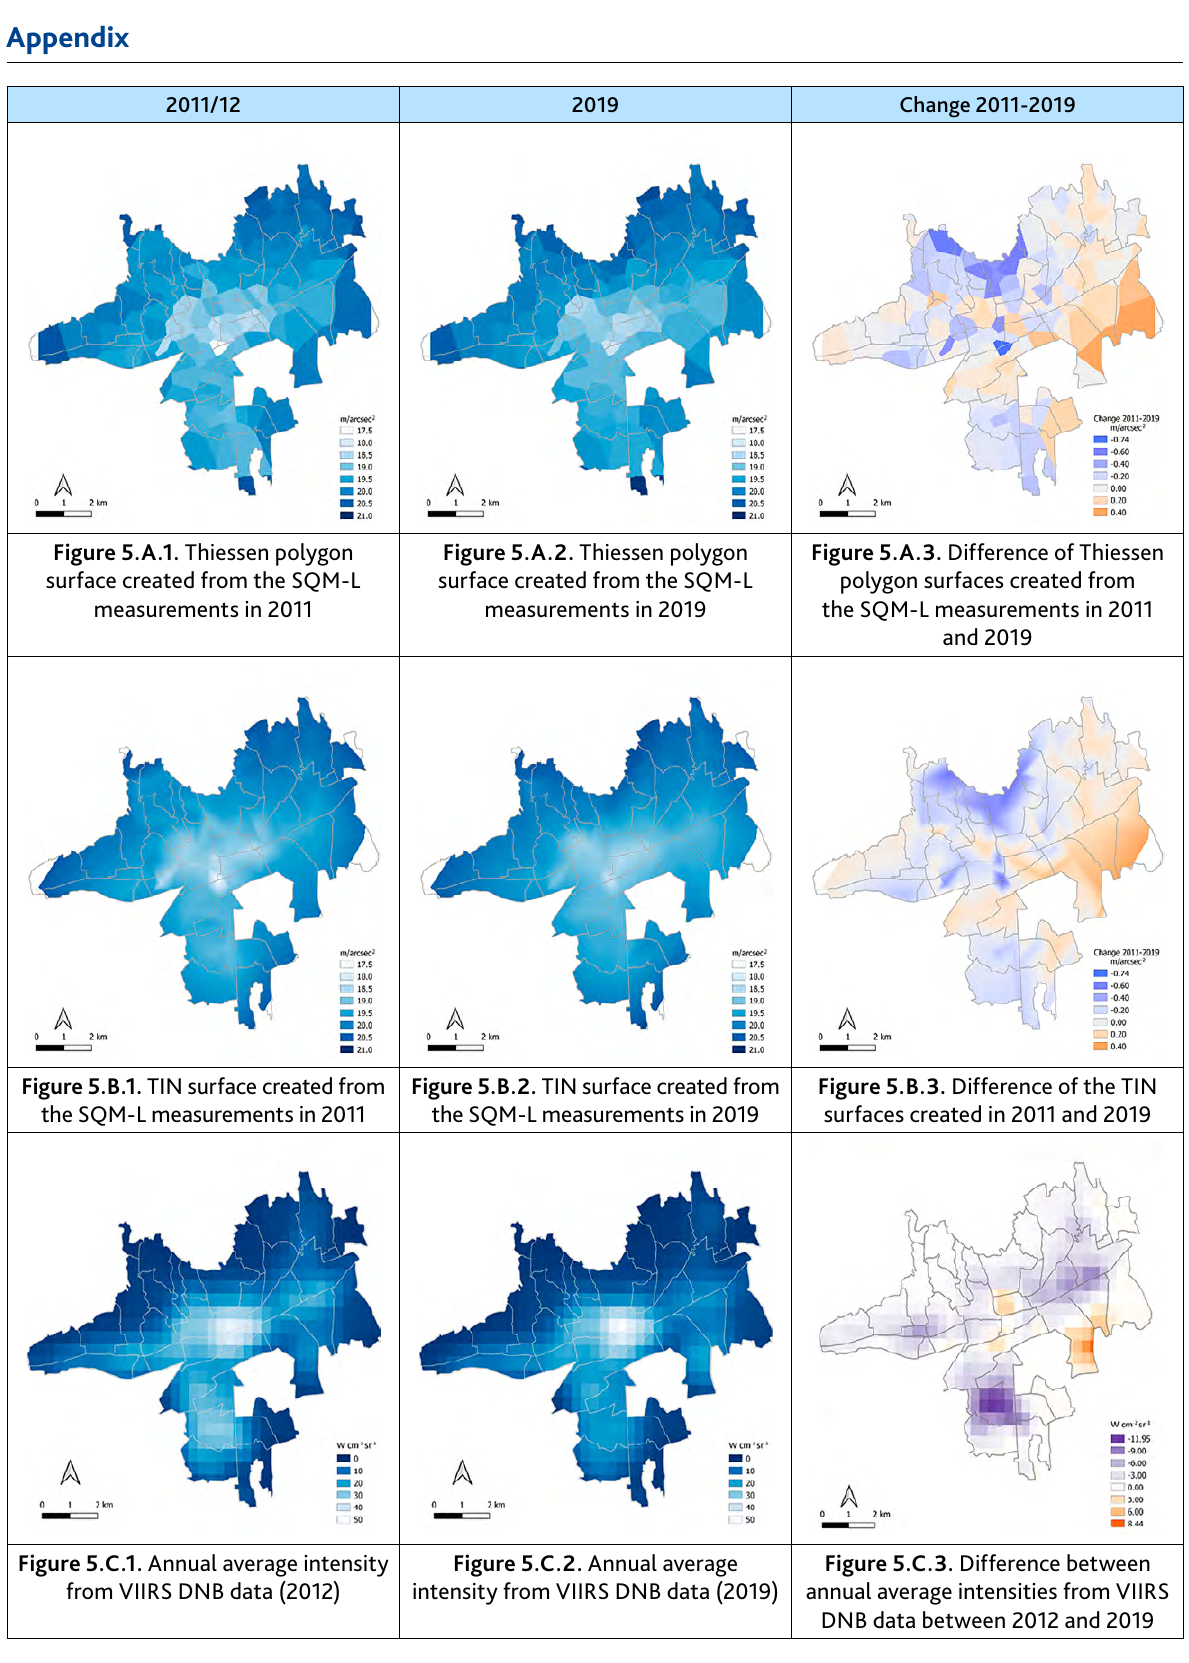
Figure 5.C.1. Annual average intensity from VIIRS DNB data (2012)